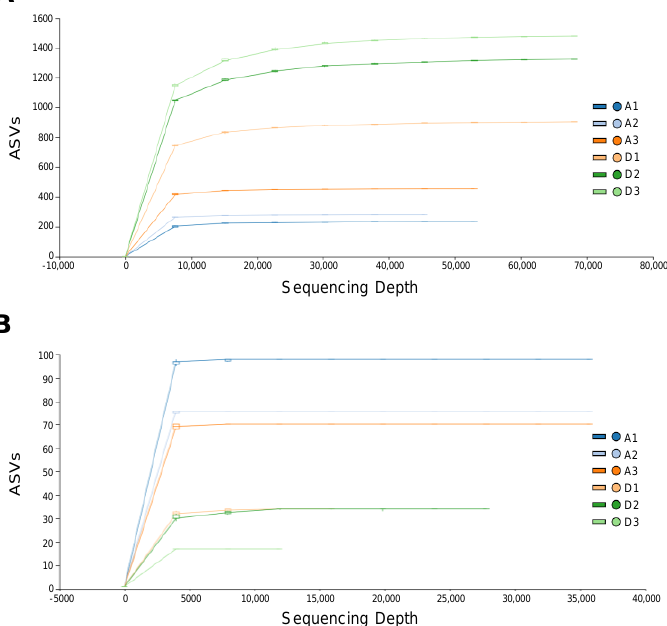
Figure 1. Rarefaction analyses of the metagenomic 16S rRNA ( A ) and fungal ITS ( B ) sequences from Korean fir trees. A1 to A3 indicate live trees and D1 to D3 indicate dead trees.